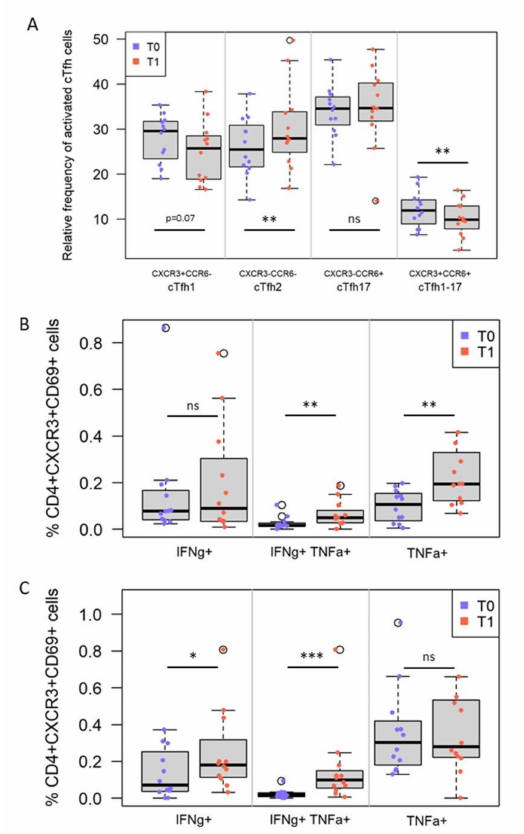
Figure 5. IMRAS vaccination induces significant differences in the frequency of antigen-specific T cell subsets. ( A ) Changes in the frequency and compositions of CSP-specific cTfh subsets after vaccination. Frequency of antigen-specific cTfh subsets (indicated on X-axis based on expression of chemokine receptors CXCR3 vs. CCR6) at baseline (pre-immune, T0 = blue dots) and pre-CHMI (T1 = red dots). Changes in the frequency of antigen-specific CD4 + CXCR3 + T cells secreting IFN γ and/or TNF α after SPZ ( B ) or CSP ( C ) stimulation before (T0) and after immunization (T1). ns = not significant, * p < 0.05, ** p < 0.01, *** p <